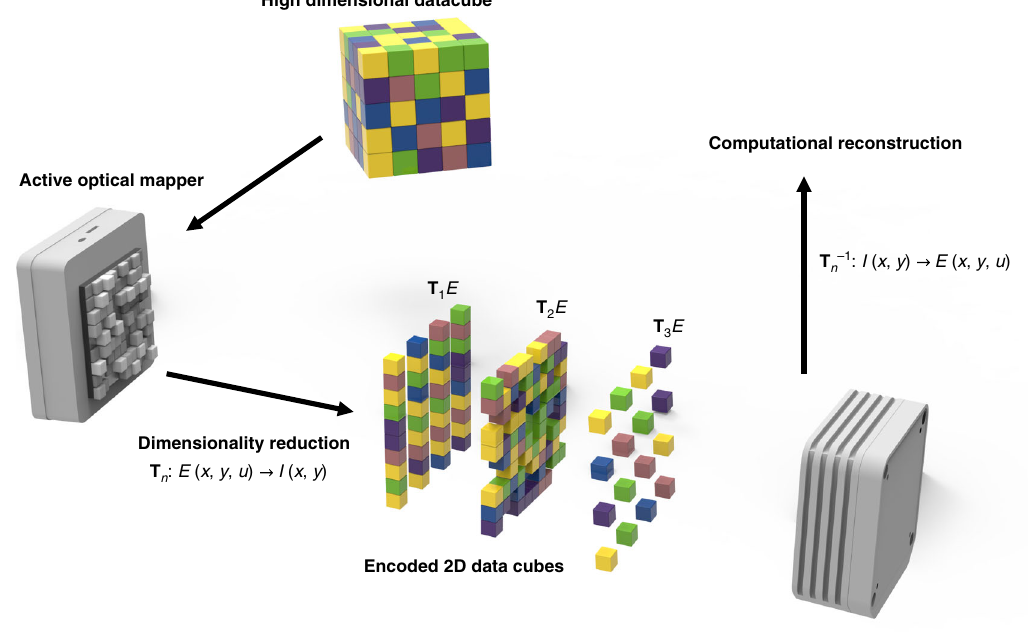
Fig. 1 Operating principle. A programmable mapper actively maps relations between a high-dimensional datacube of an incident light and a 2D image sensor on demand. With the mapping relations and the acquired 2D image data, the high-dimensional datacube can be computationally